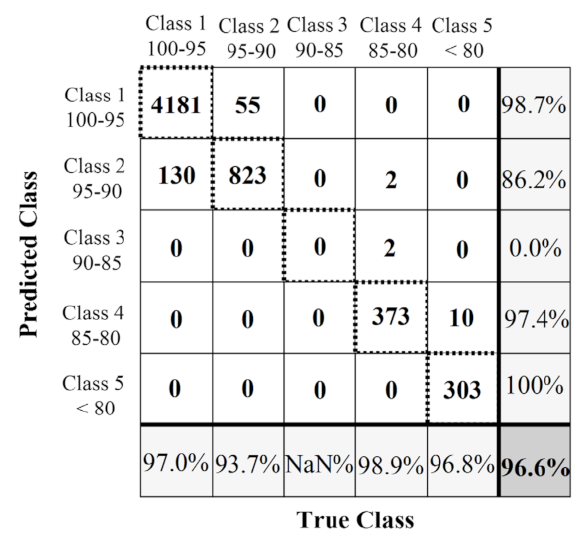
Figure 15. Confusion matrix for performance analysis of ANN-based classifier under constant charge current profile validation. The diagonal cells are correctly classified buffers. The last row with gray background is the TPR. The last column with gray background is the precision per class. The bottom right cell with dark background is the total accuracy.